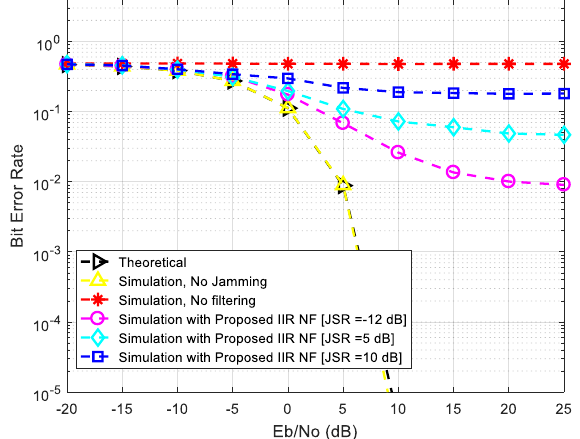
𝑬 𝒃 in the presence of CWI. 𝑵 𝒐